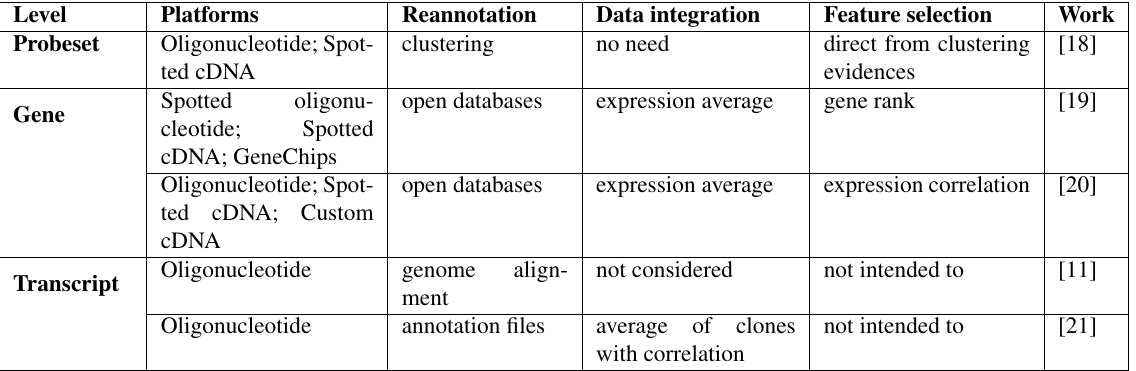
Table 1: Related